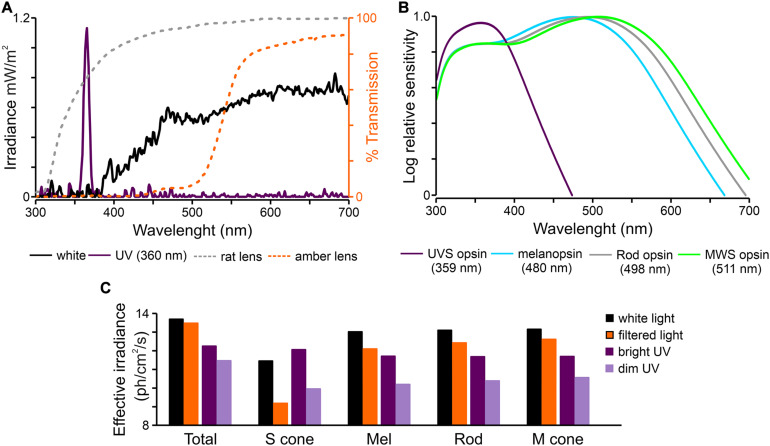
Characteristic of light stimuli used in the study. (A) Spectral transmission profiles of polychromatic white and monochromatic UV (360 nm) light used in the present study and corresponding transmission of rat lens (Jacobs et al., 2003) and amber lens (Prima 67 or Igel RX SPHERE; UltraVision, United Kingdom). (B) Overlapping spectral sensitivity of rat photoreceptors. (C) Effective irradiances for each type of photoreceptors produce by light stimuli presented in panel (A) (Lucas et al., 2014). UV – monochromatic light (360 nm).